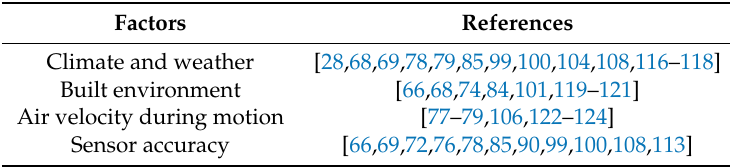
Table 3. Literature related to factors affecting barometric